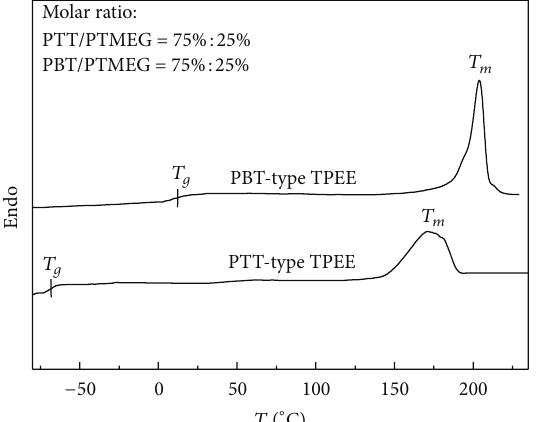
Figure 10: DSC melting curves of two copolymers.